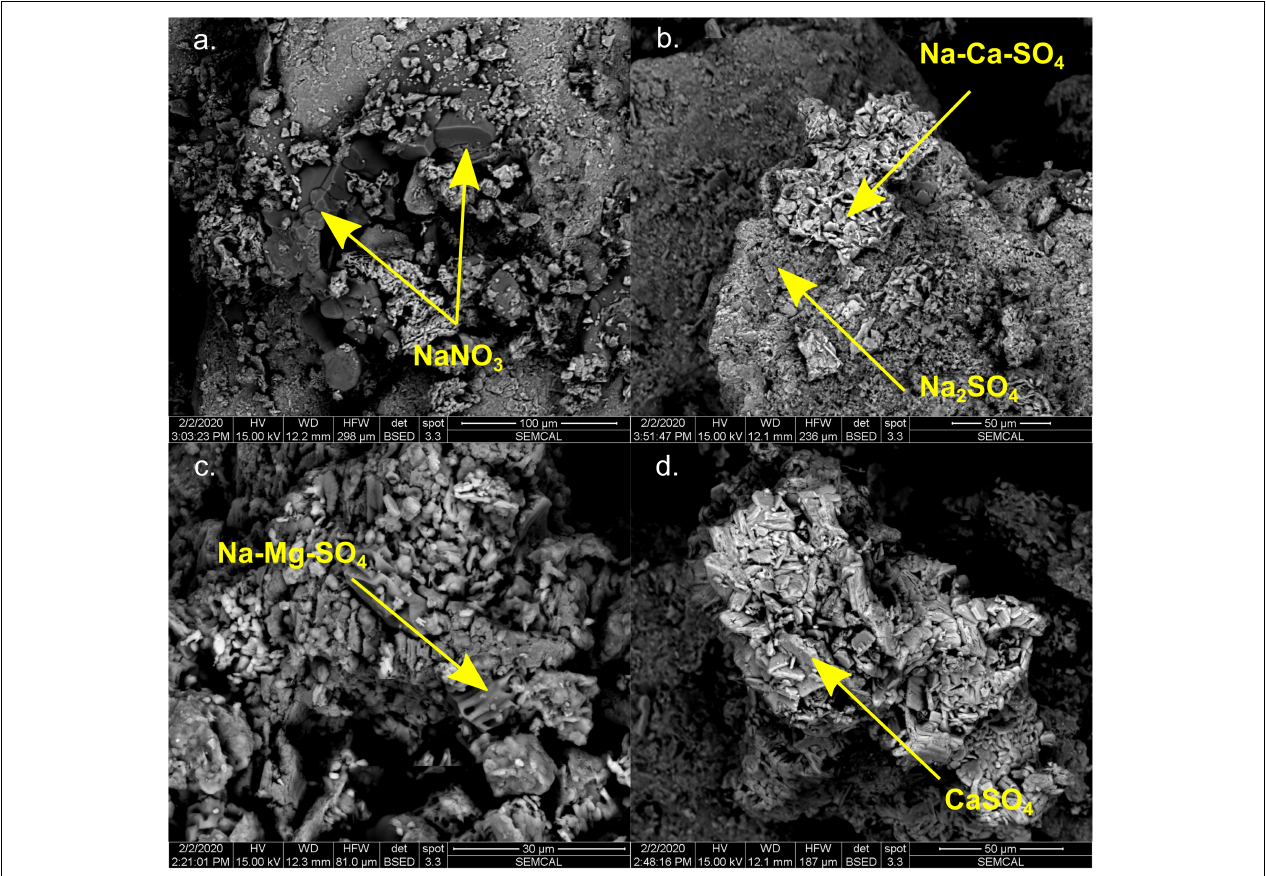
FIGURE 5 | Scanning electron microscopy (SEM) backscatter emission (BSE) images of salt encrustations from Schroeder Hill. The salts include soda nitre (NaNO 3 ) (a) , and a variety of sodium, magnesium, and calcium sulfate salts (b–d) . The chemical composition of the salts was determined by energy dispersive x-ray spectroscopy